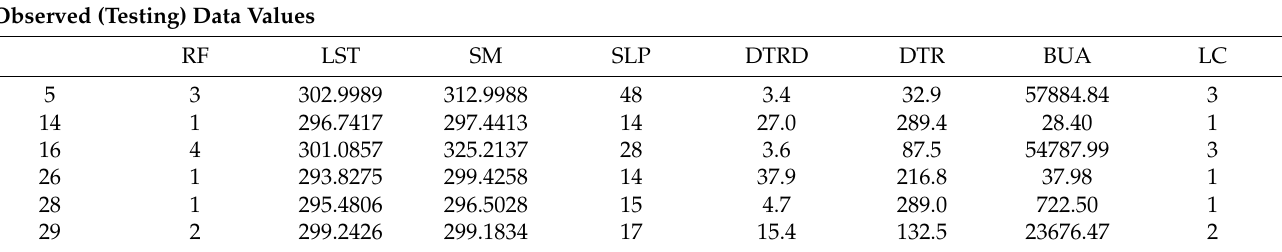
Table 7. Testing data values used as observational datasets for Landslide chances.